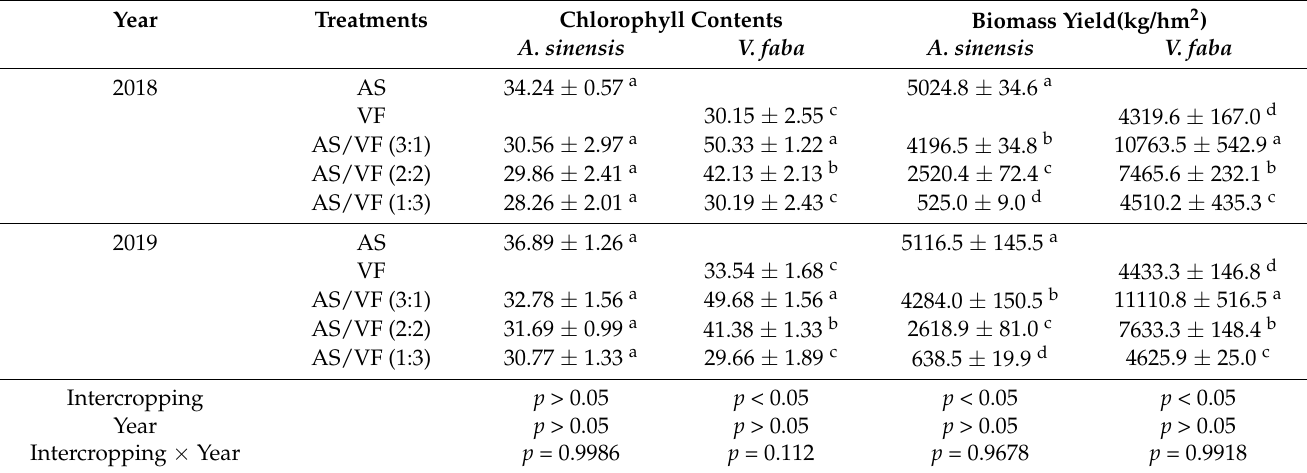
Table 3. Chlorophyll contents and biomass yields of A. sinensis and V. faba under different cropping systems in 2018 and in 2019 1